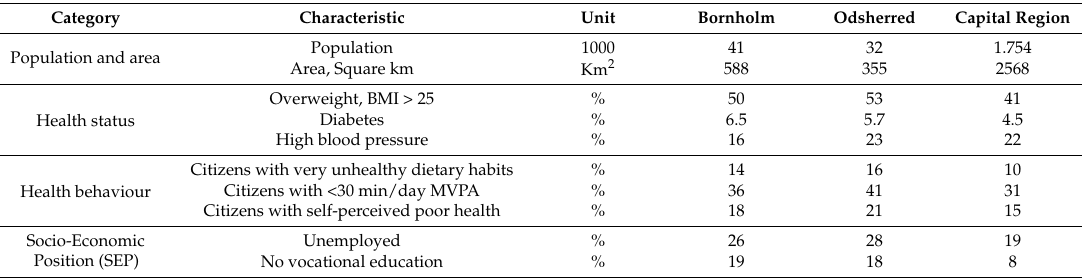
Table 1. Important characteristics of the adult citizens (>16 years) in Bornholm and Odsherred municipalities compared to the Capital